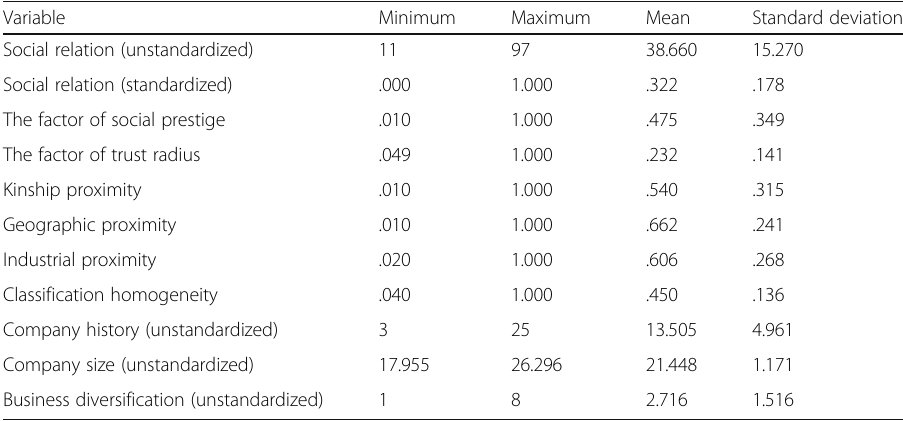
Table 2 Descriptive statistics of main variables N =